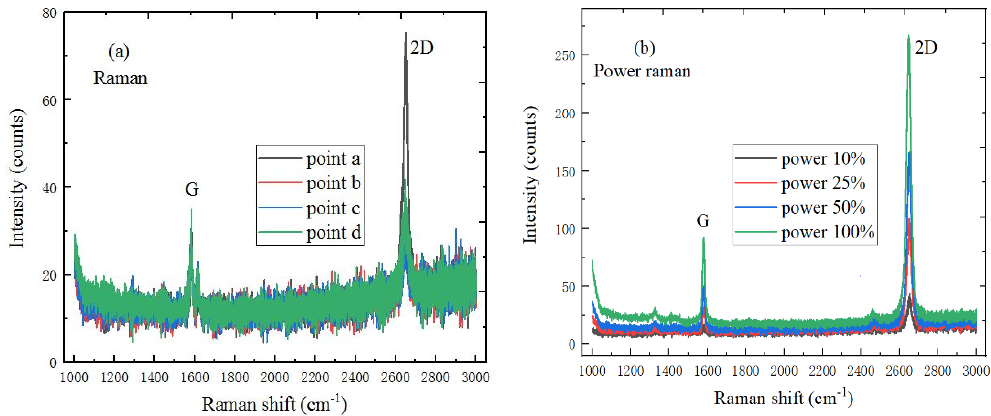
Figure 2. Spectral characteristics of graphene ( a ) Raman spectrum (10 mW, 633 nm), ( b ) Power Raman spectrum (2 mW, 5 mW, 10 mW, 20 mW and 633 nm).